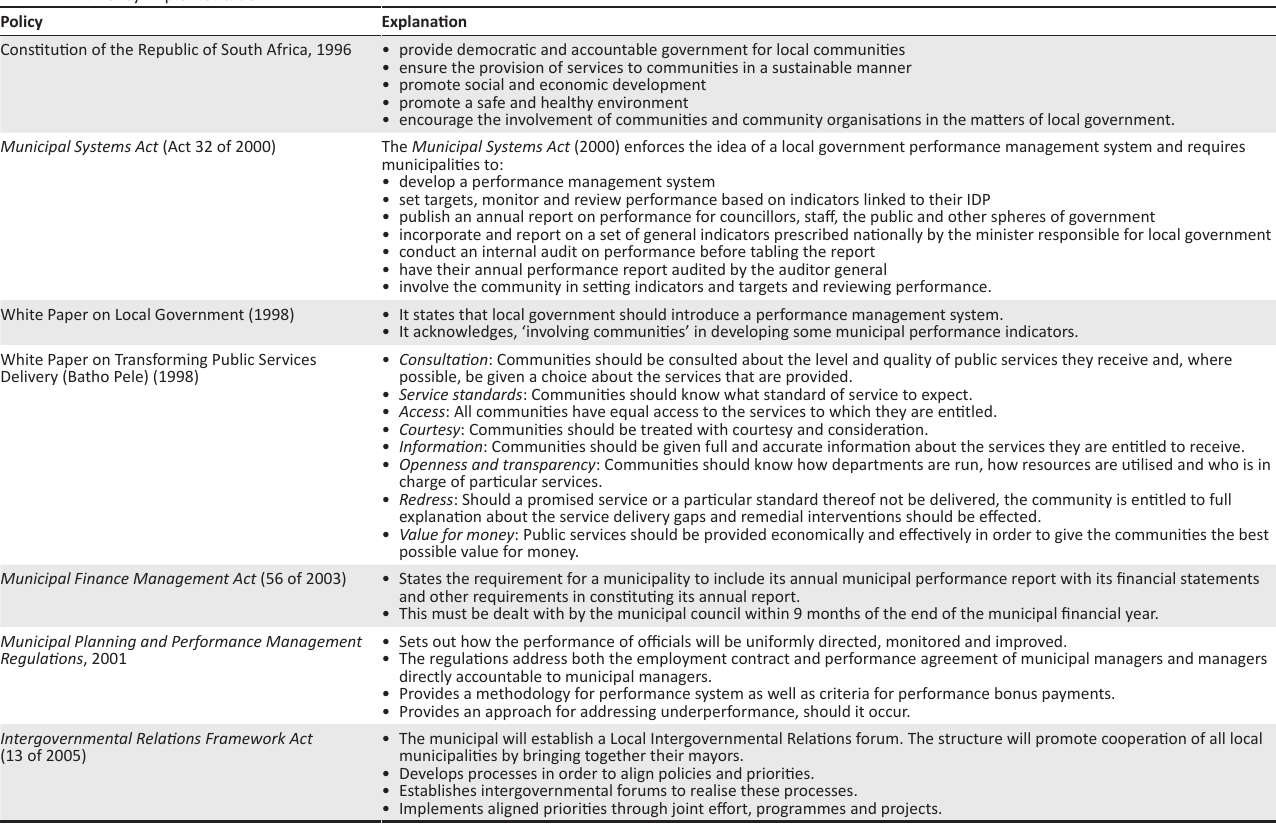
TABLE 1-A1: Policy